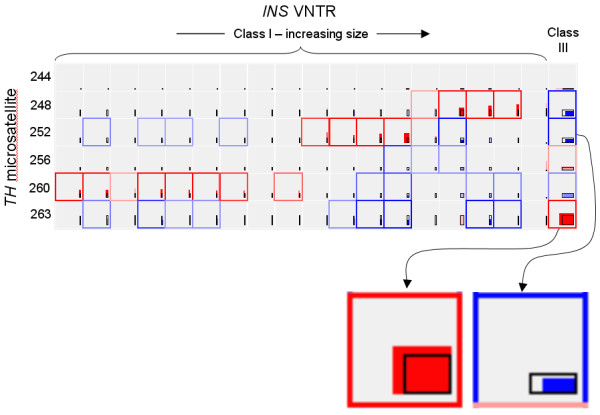
LD between the INS VNTR and the TH01 microsatellite. Each TH01 allele associates with a size range of VNTR alleles (256 and 263 associate with the class III alleles). This infers a greater rate of mutation in the VNTR because there is a wider range of allele sizes in the VNTR dimension significantly associated with TH01 alleles than vice versa. Close-ups of individual allele plots are shown to indicate the magnitude of effect – black rectangle indicates expected haplotype frequency under no LD, coloured rectangle indicates the estimated haplotype frequency.